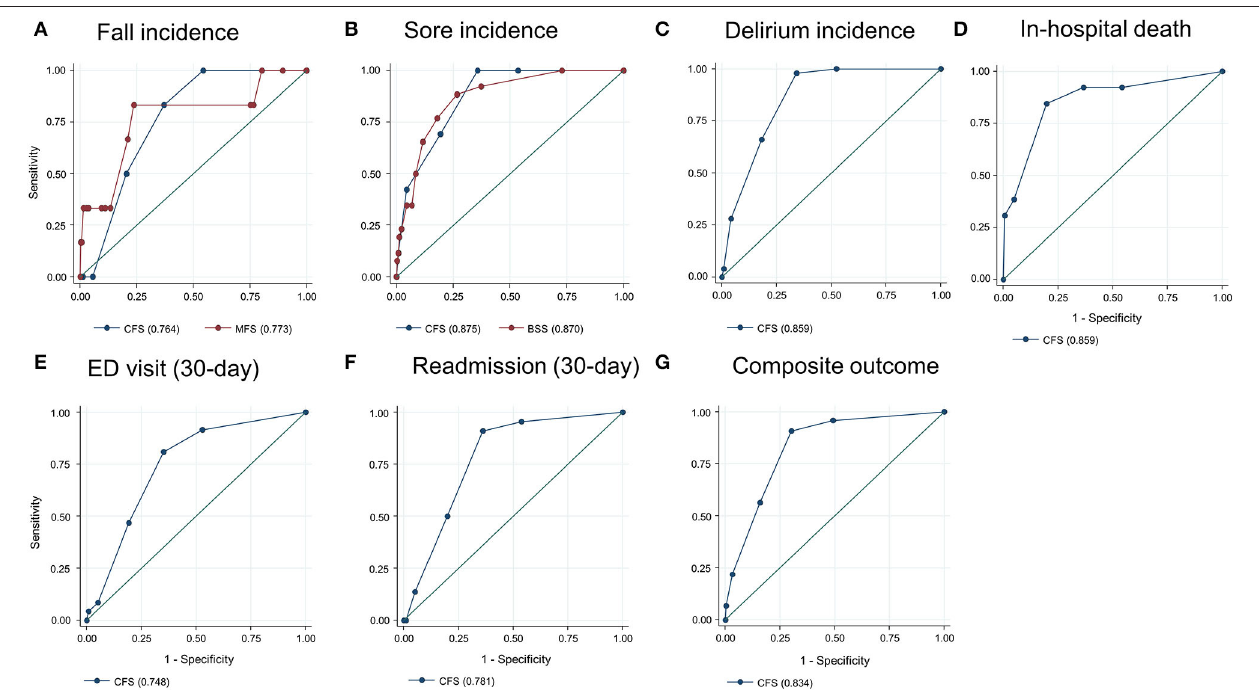
FIGURE 2 | Prediction ability of the Clinical Frailty Scale (CFS) for fall incidence [ (A) , compared with the Morse Fall Scale (MFS)], sore incidence [ (B) , compared with the Braden Sore Scale (BSS)], delirium incidence (C) , in-hospital mortality (D) , 30-day emergency department (ED) visit (E) , unplanned 30-day readmission (F) , and composite outcome (G) . Numbers in parentheses denote the area under the